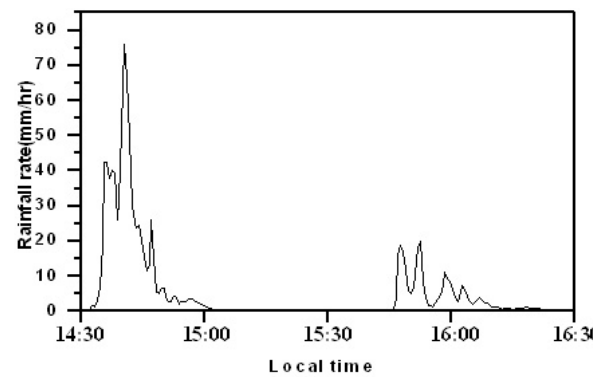
Fig. 6. Rainfall measurements as observed on 25 May